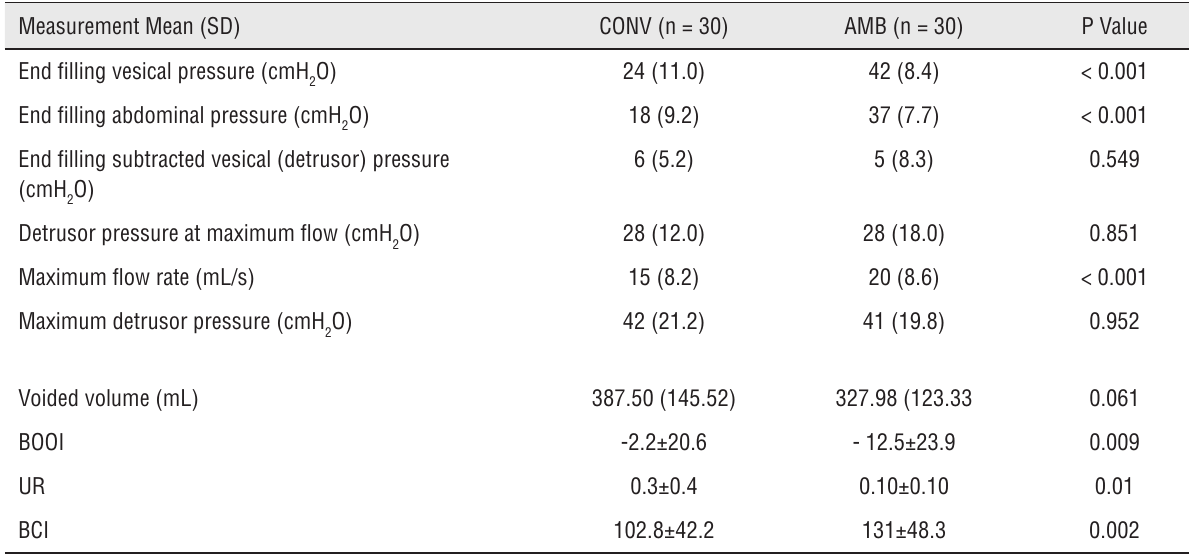
Table 2 - Summary statistics for intra-individual differences in urodynamic measurements during conventional cistometry (CONV) and ambulatory urodynamic monitoring (AMB).